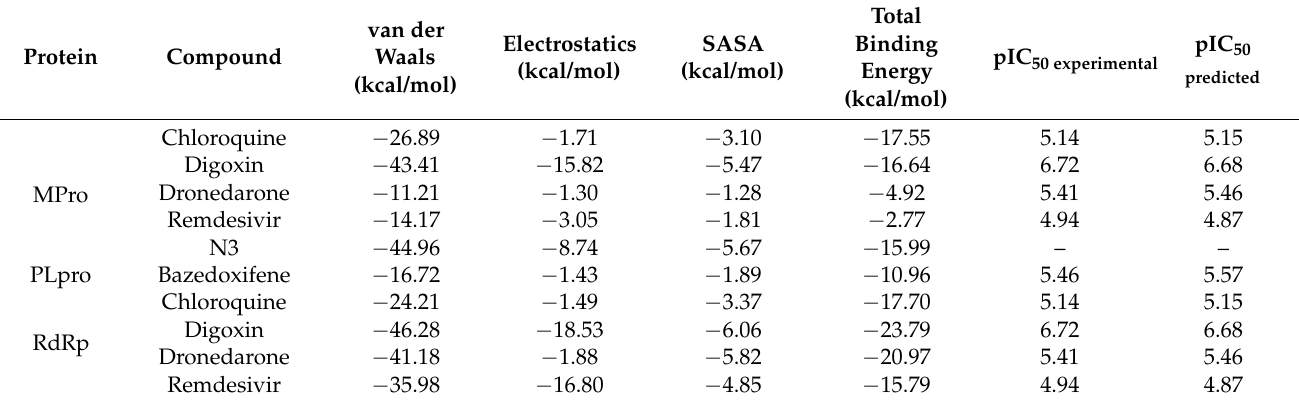
Table 7. Energy contributions to the total binding energy of the protein-ligand interaction in the three evaluated targets.